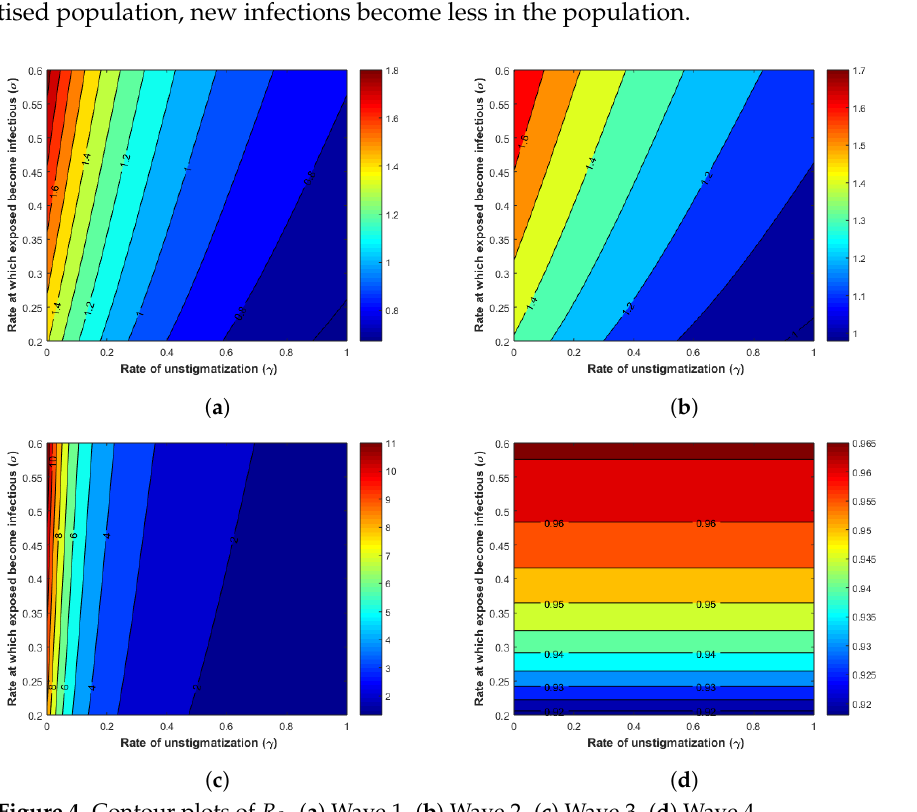
Figure 4. Contour plots of R 0 . ( a ) Wave 1. ( b ) Wave 2. ( c ) Wave 3. ( d ) Wave